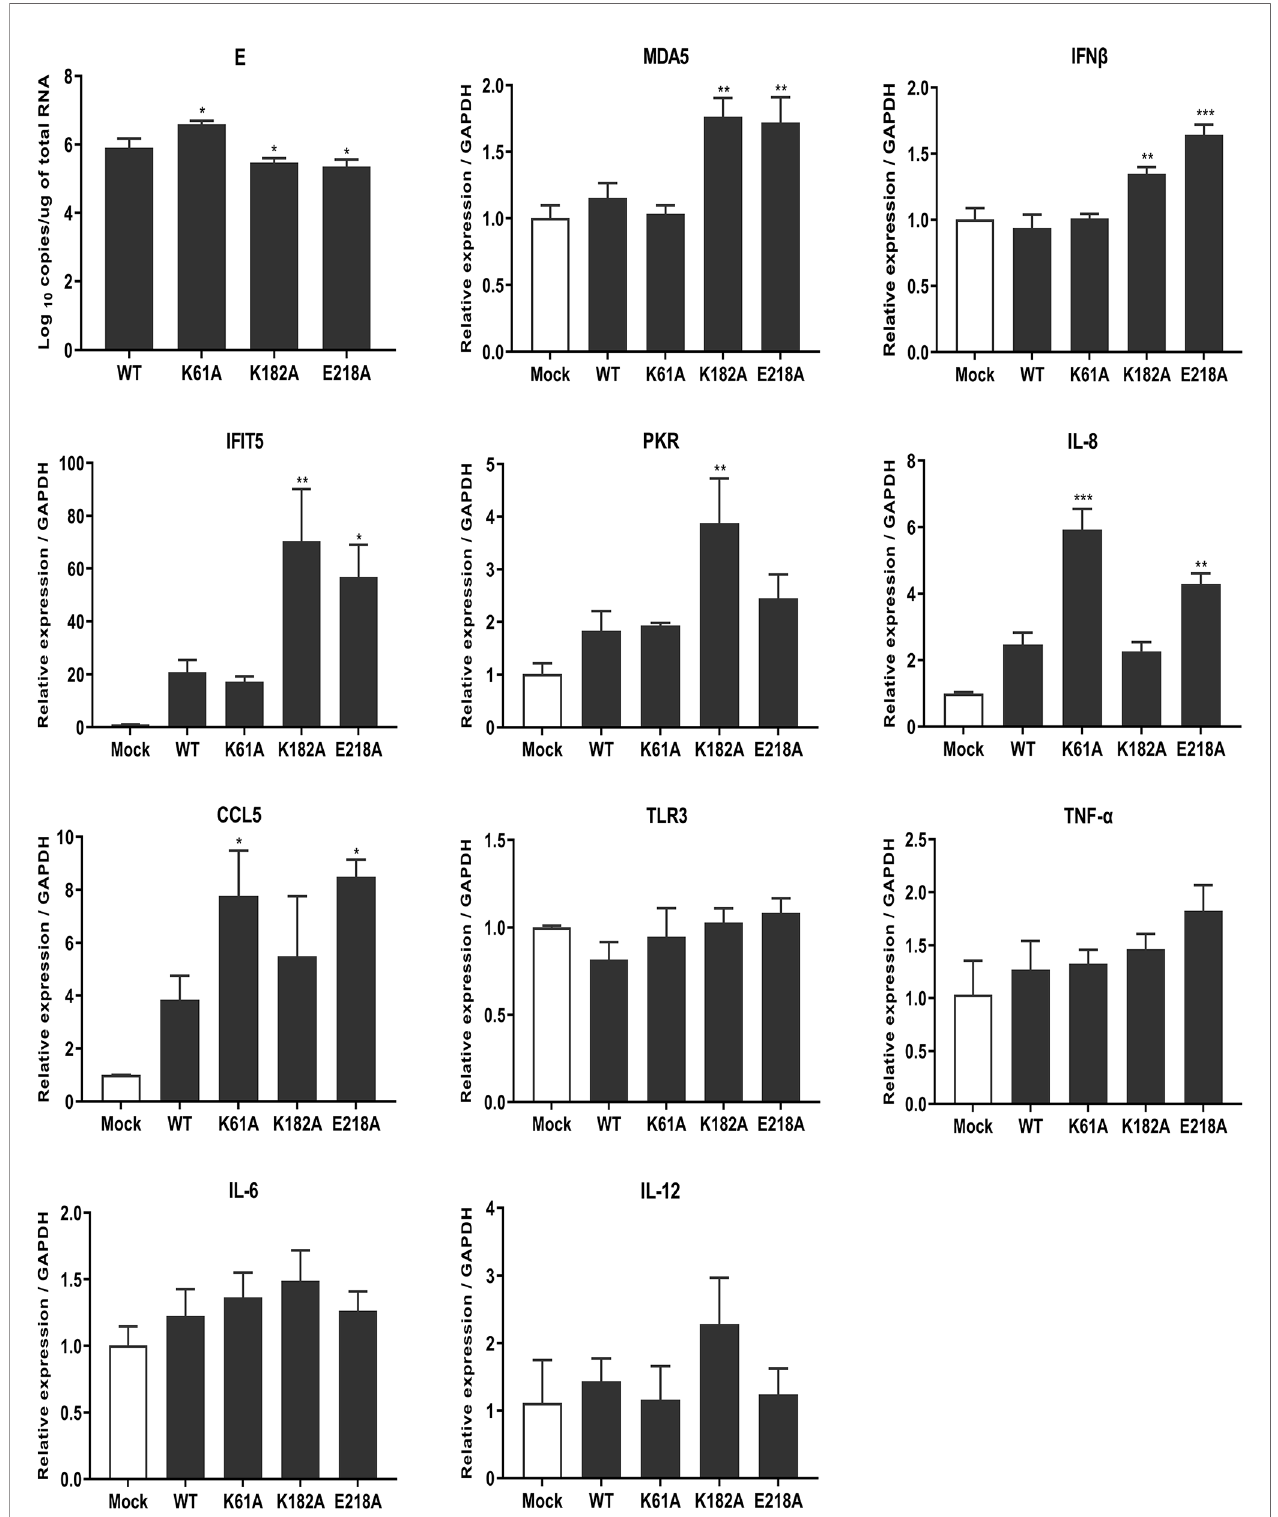
FIGURE 7 | Mutant TMUVs induce a higher innate immune response. DEF cells were infected with 0.01 MOI of WT, K61A, K182A and E218A viruses, respectively. At 24 hpi, cells were harvested and transcription levels of cytokines were measured by qPCR. Each of these was conducted with three parallel replicates. Bars show means ± SDs. *** P < 0.001; ** P < 0.01; * P < 0.05 (one-way